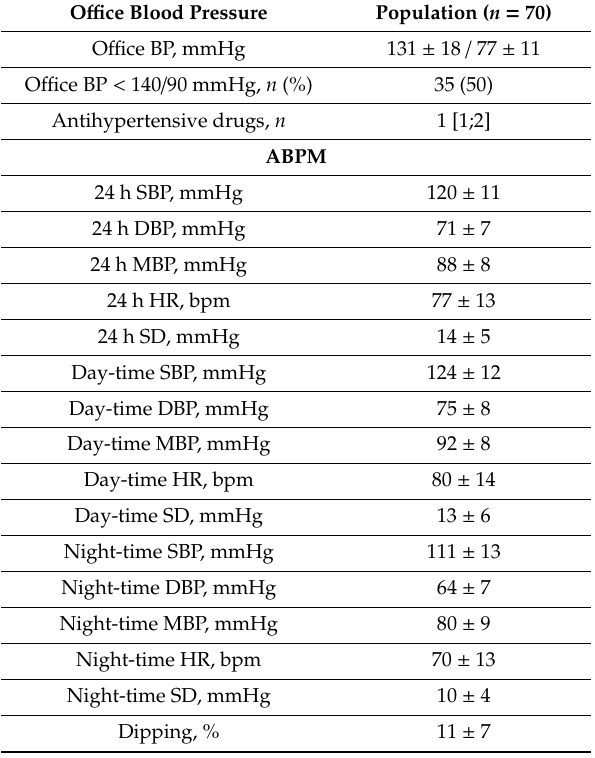
Table 2. O ffi ce blood pressure and ambulatory blood pressure monitoring